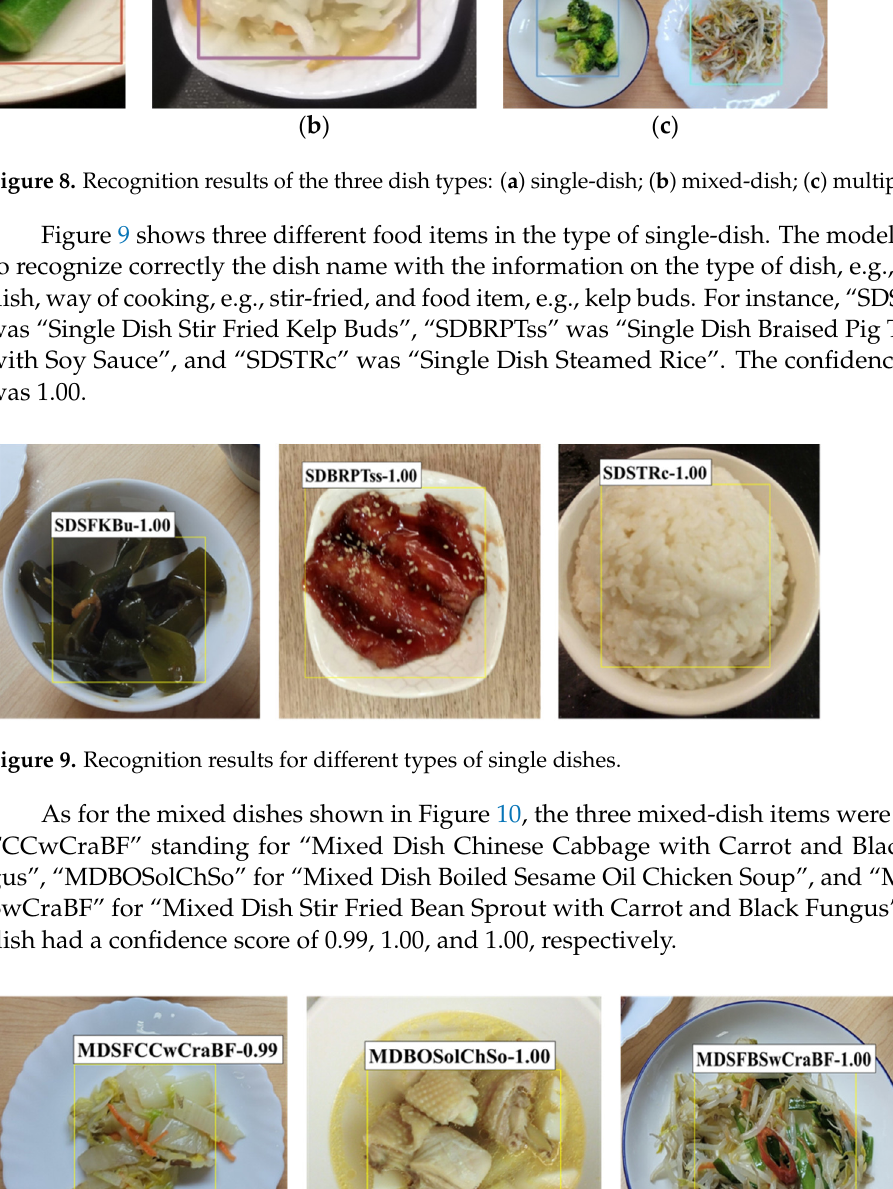
( d ) Figure 11. Recognition results for multiple dishes with different number of dishes (T): ( a ) T = 3, ( b ) T = 4; ( c ) T = 5; ( d ) T = 6.